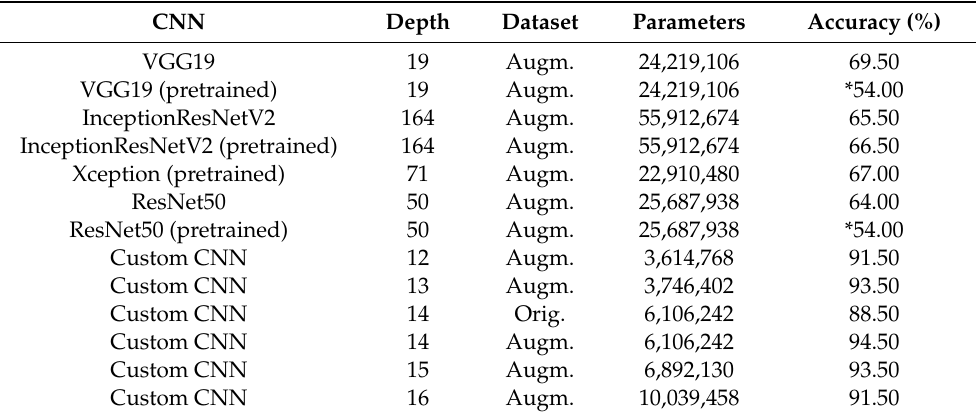
Table 1. Performance comparison of various CNN models (max. 100